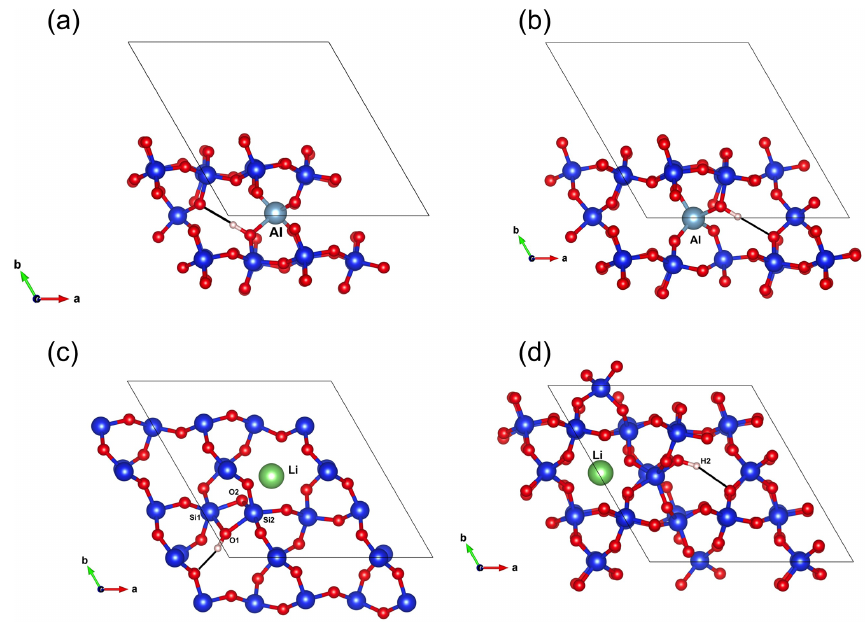
Figure 7. (a) Structure of the (Al,OH)_2 defect. (b) Structure of the (Al,OH)_1 defect. (c) Structure of the (Li,OH)_1 defect. (d) Structure of the (Li,OH)_2 defect.